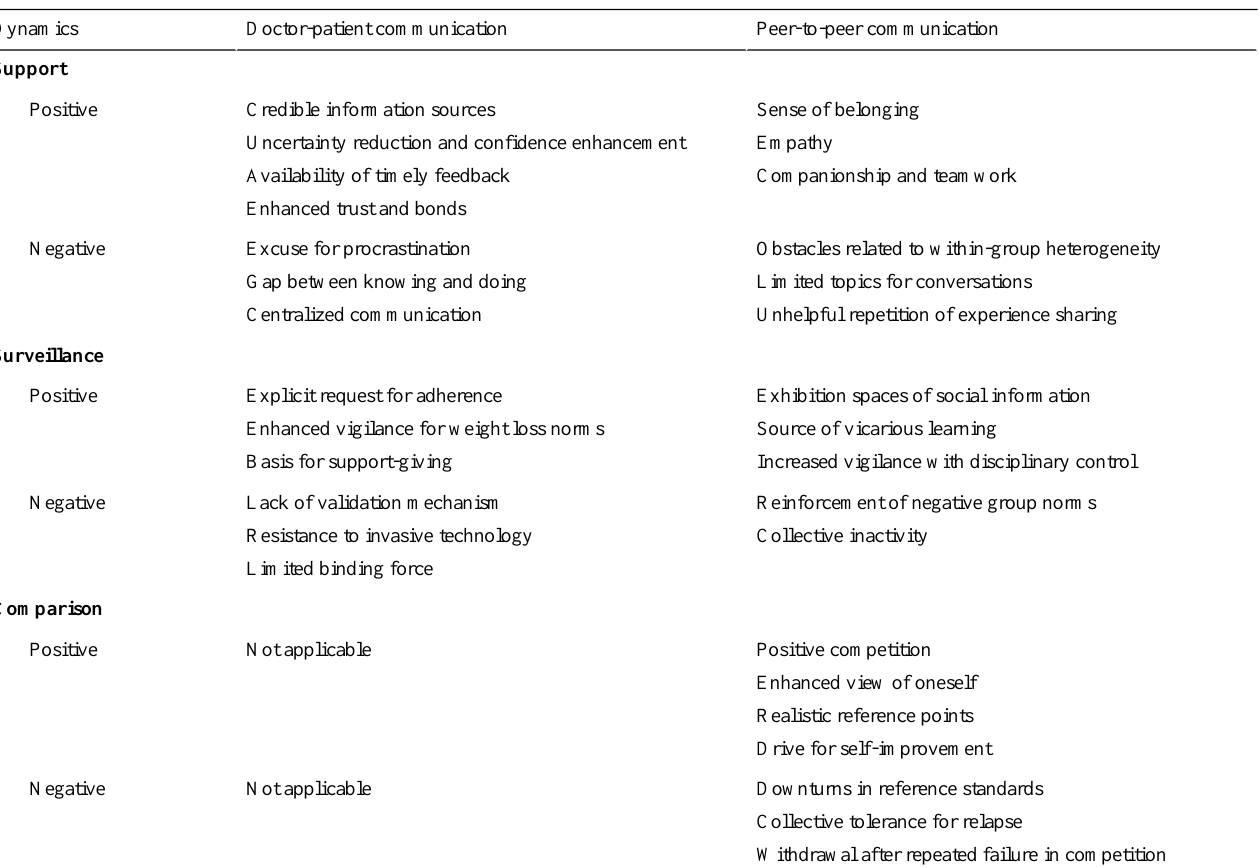
Table 4. Social influences of social media